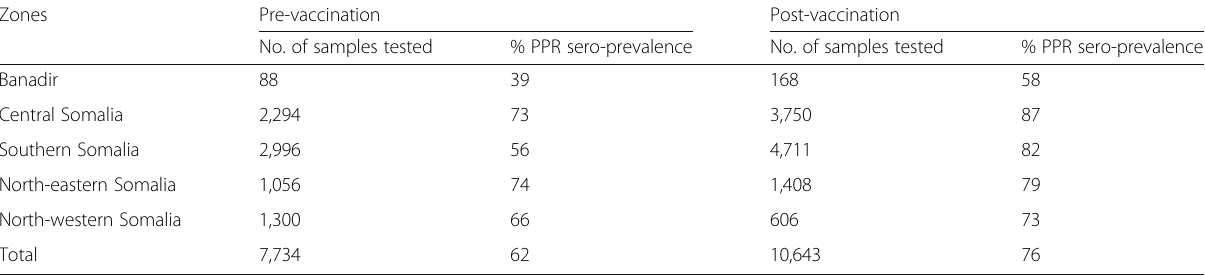
Table 6 Analyses of PPR serum samples collected from small ruminants before and after PPR vaccination in the five zones in Somalia, 2012